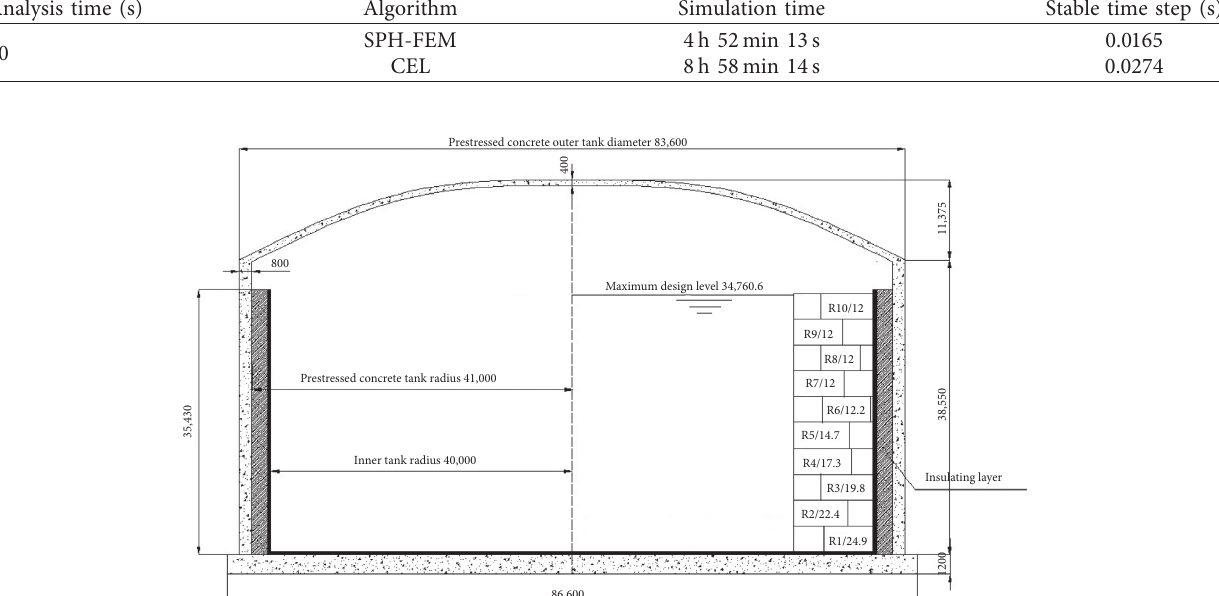
Figure 6: LNG storage tank cross section (unit: mm). Table 3: Thickness of each layer in the inner tank. Layer